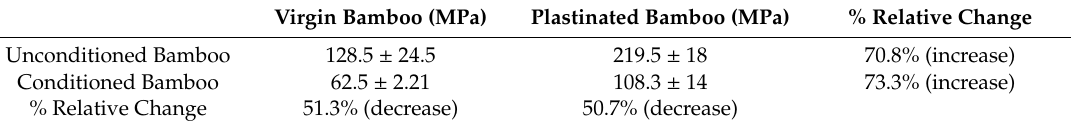
Table 2. Tensile strength comparison of di ff erent bamboo specimens tested.